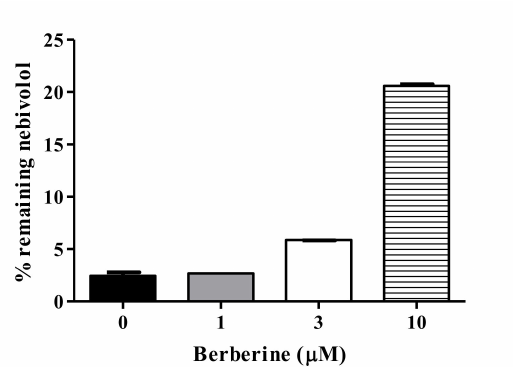
Figure 6. E ff ects of BBR on nebivolol metabolism in pooled HLM. Nebivolol (1 µ M) was incubated with pooled HLM (1 mg / mL) in the presence or absence of BBR at various concentrations for 60 min. Data are presented as the mean ± SD of three separate